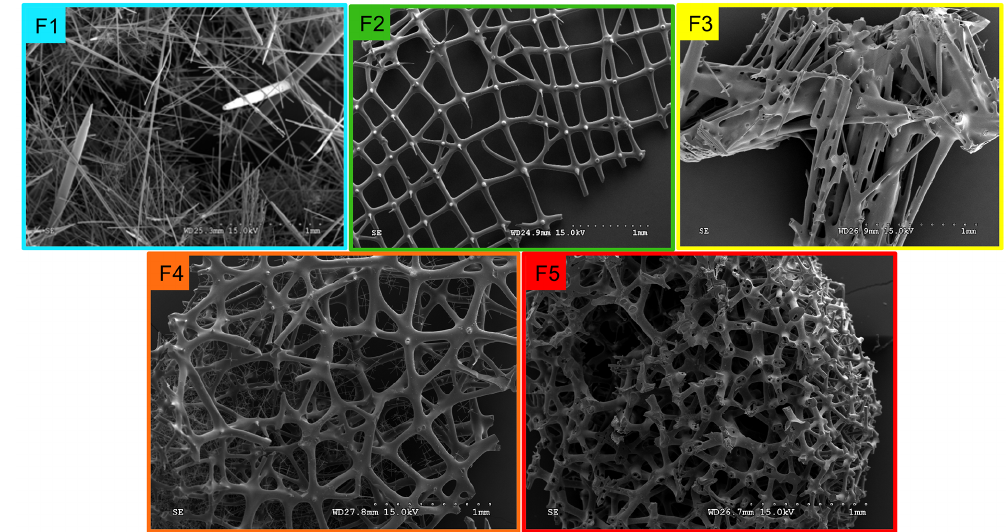
Figure 3. Level of fusion of sponge spicules from the equatorial Atlantic. F1 (blue) loose spicule, F2 (green) net-like, F3 (yellow) additional silica coating, F4 (orange) light dictyonal skeleton and F5 (red) dense dictyonal skeleton. Table 1. Criteria of the five levels of sponge spicule fusion. See Fig. 3 for the corresponding picture. Fusion level Given name Class Description F1 Loose Demospongiae/Hexactinellida Single loose microsclere and/or megasclere spicules Net-like Hexactinellida Spicules fused perpendicularly fused by a node forming a relatively regular two-dimensional net Hexactinellida